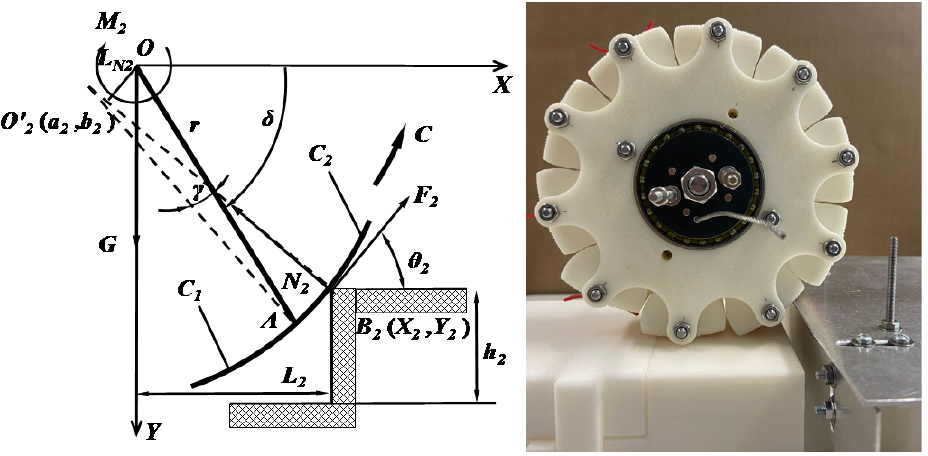
Figure 5. Mechanical analysis of C 2 section in deformation state ( Left : force diagram; Right : actual contact).